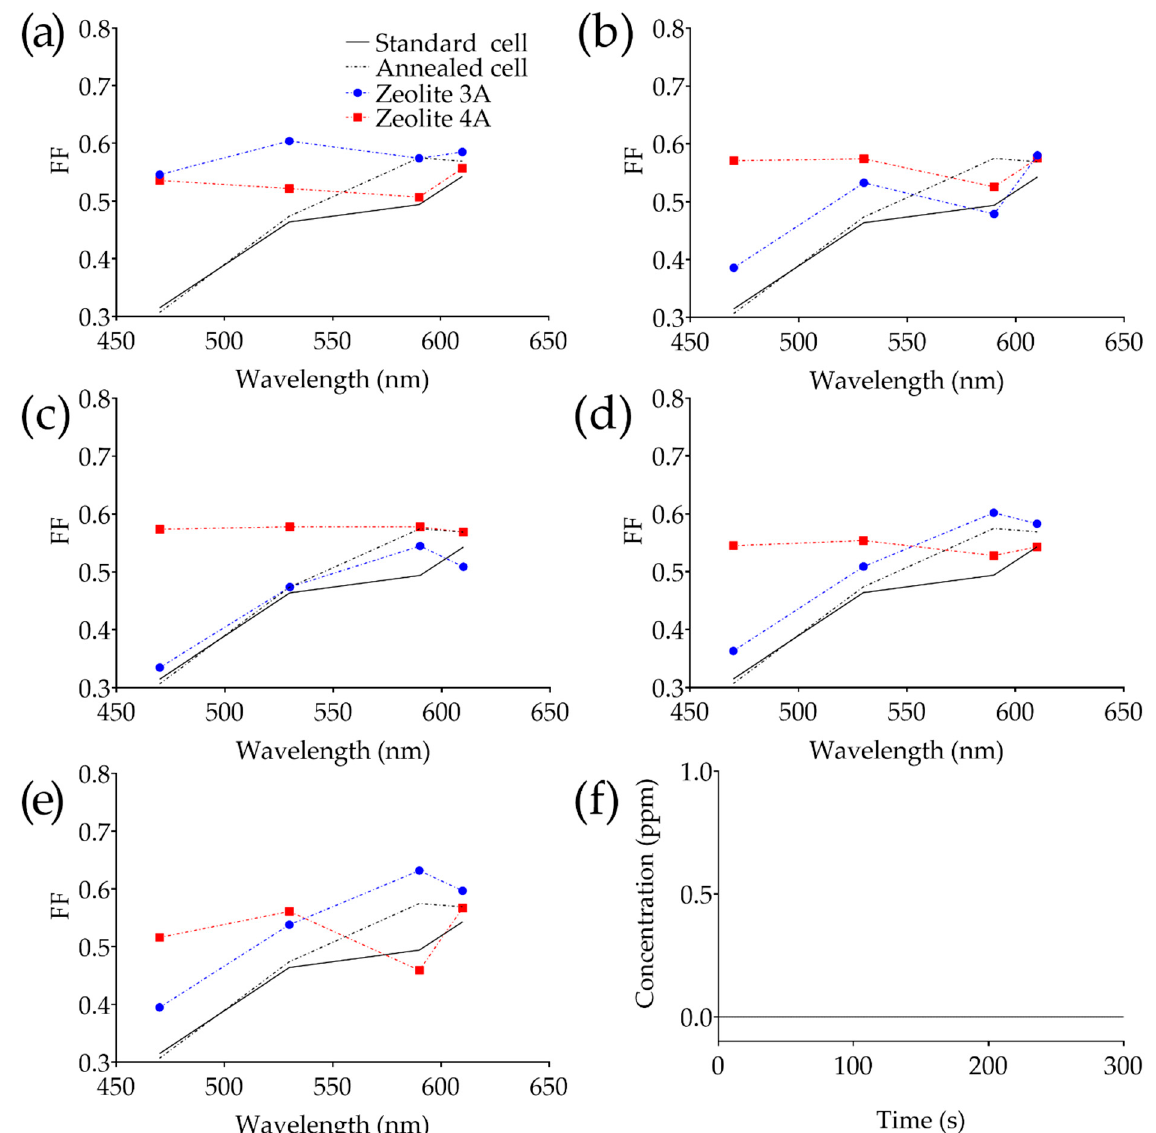
Figure 4. Fill factor vs. wavelength for anti-reflective layer deposited at ( a ) 2000 rpm, ( b ) 3000 rpm, ( c ) 4000 rpm, ( d ) 5000 rpm and ( e ) 6000 rpm. ( f ) Representative emission profiles of solar cells coated with zeolite 3A and 4A at 2000 rpm.